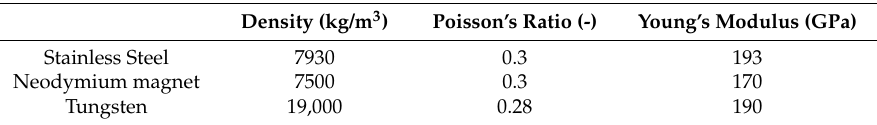
Table 2. Material properties.